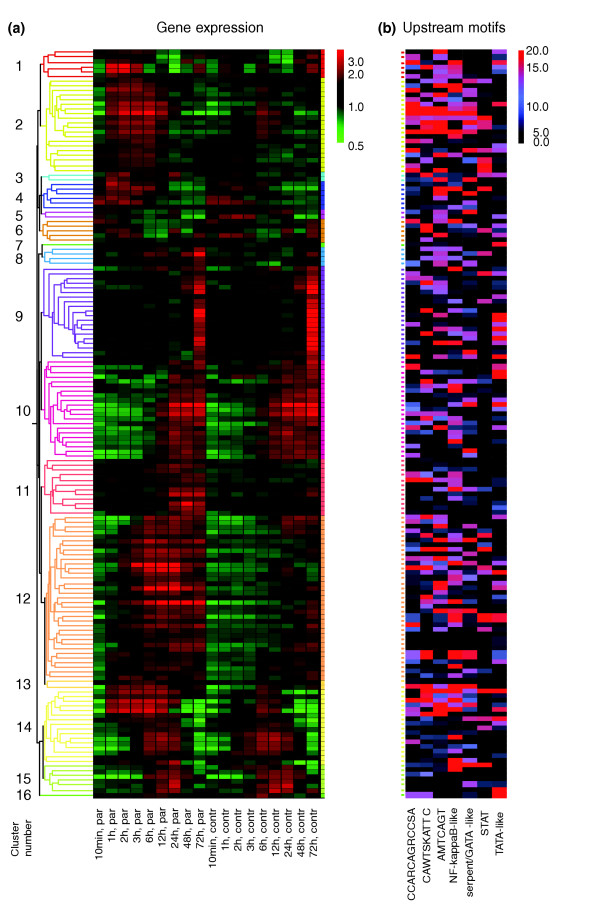
Gene expression levels and distribution of regulatory motifs for the genes differentially expressed after parasitoid attack. (a) Expression levels for genes (rows) at different sample time points (columns: 1-9 parasitized larvae; 10-18 unparasitized larvae). The expression levels are given as multiples of the median for that gene, using a color code illustrated at top right. At the left the dendrogram produced by the clustering algorithm is shown, with the 16 clusters discussed in the text depicted in different colors (with their code numbers; the final column on the right shows the clusters again using the same color key). (b) The distribution of putative regulatory motifs in the -1,000 to +50 base pair upstream regions of the genes. The colors indicate the number and strength of the matches for each motif (see code on upper right, in which a score of 0 is equivalent to no matches, 10 is equivalent to one strong or two weak matches, and 20 is equivalent to multiple strong matches).